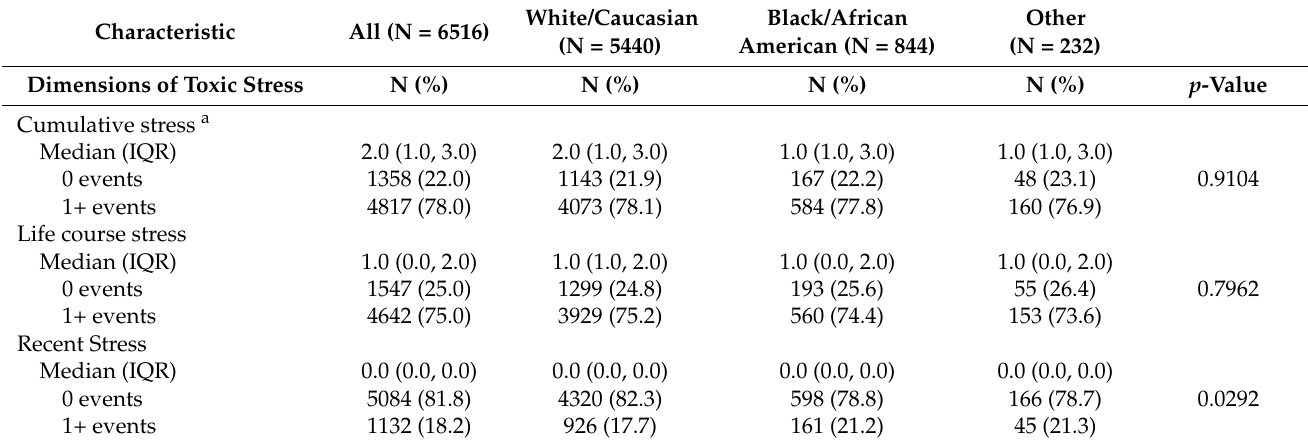
Table 1. Distribution of toxic stress and resilience promoting factors among older Americans enrolled in the HRS 2006–2016 sample at baseline by